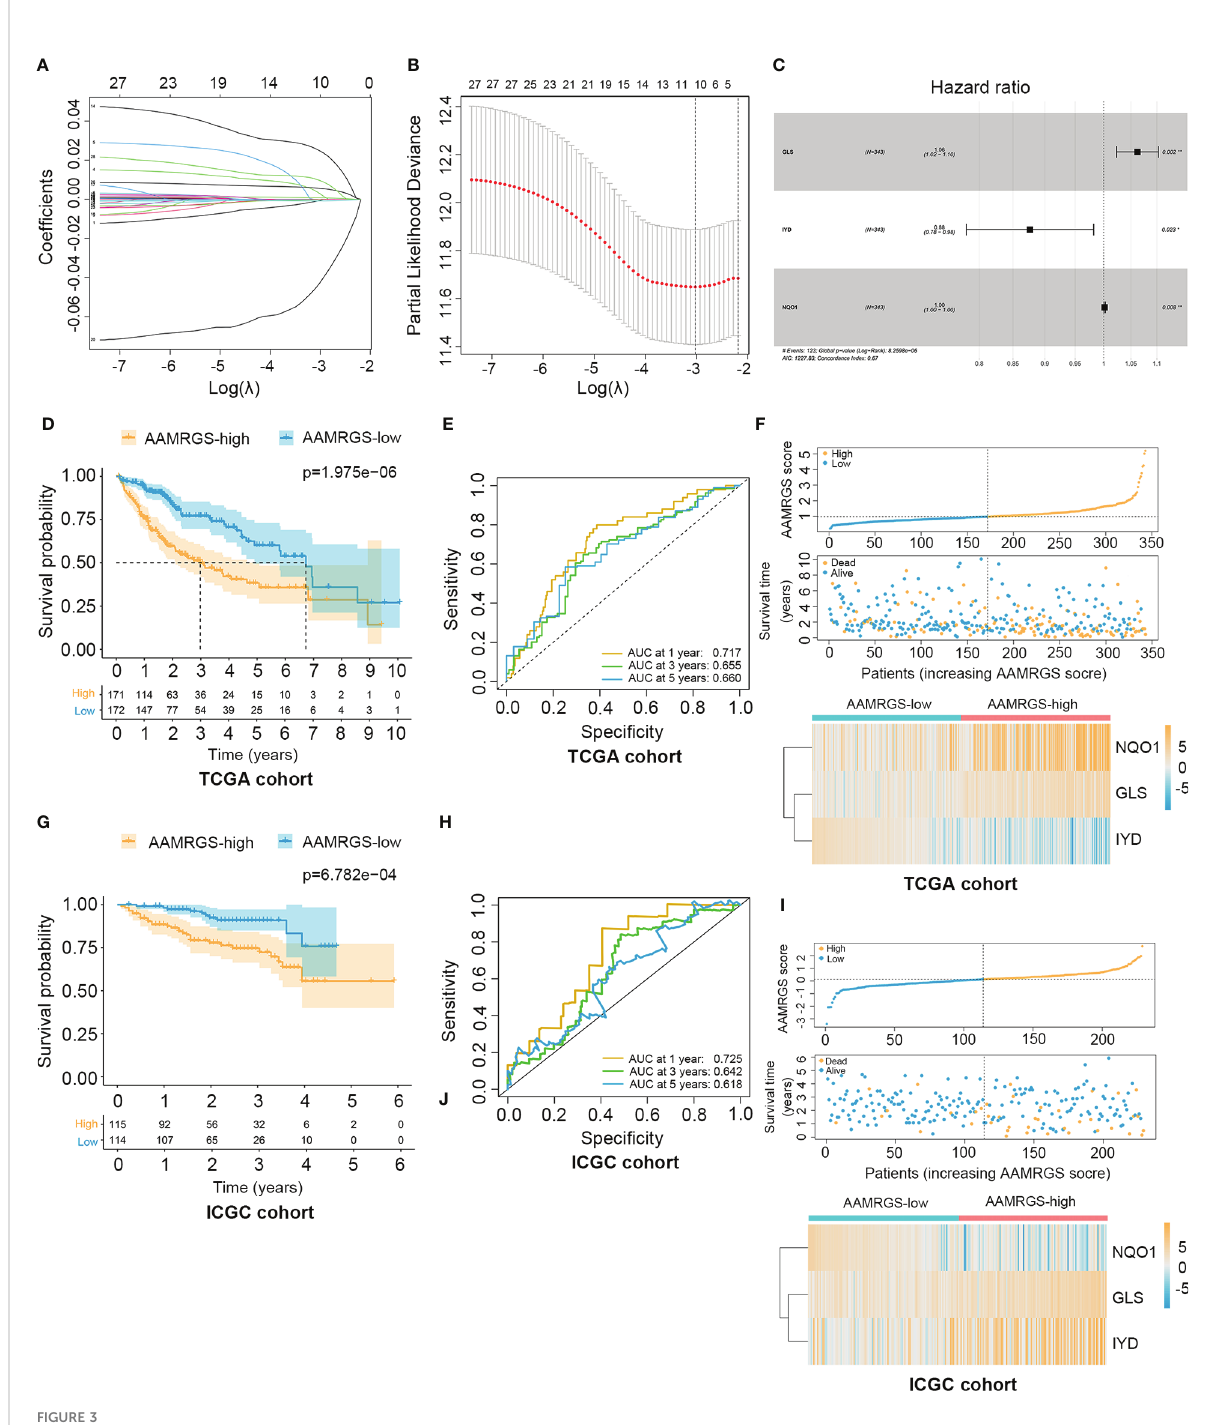
FIGURE 3 Construction of the AAMRGS and assessment of its prognosis value in TCGA and ICGC cohorts. (A) Variation of LASSO coef fi cients in different tuning parameters ( l ). (B) Partial likelihood deviance was plotted against log ( l ), where l was the tuning parameter. (C) Forest plot of three AAMRGs screened by multivariate Cox regression analysis. (D) Difference in survival time between the AAMRGS-high and the AAMRGS-low groups in the TCGA cohort. (E) ROC analysis for the AAMRGS at one, three, and fi ve years in the TCGA cohort. (F) The distribution of the AAMRGS score, survival status of patients, and expression level of three AAMRGs between the two AAMRGS subgroups in the TCGA cohort. (G) KM survival analysis for the ICGC cohort. (H) ROC curves for the ICGC cohort. (I) The distribution of the AAMRGS score, survival status of patients, and expression level of three AAMRGs between the two AAMRGS subgroups in the ICGC